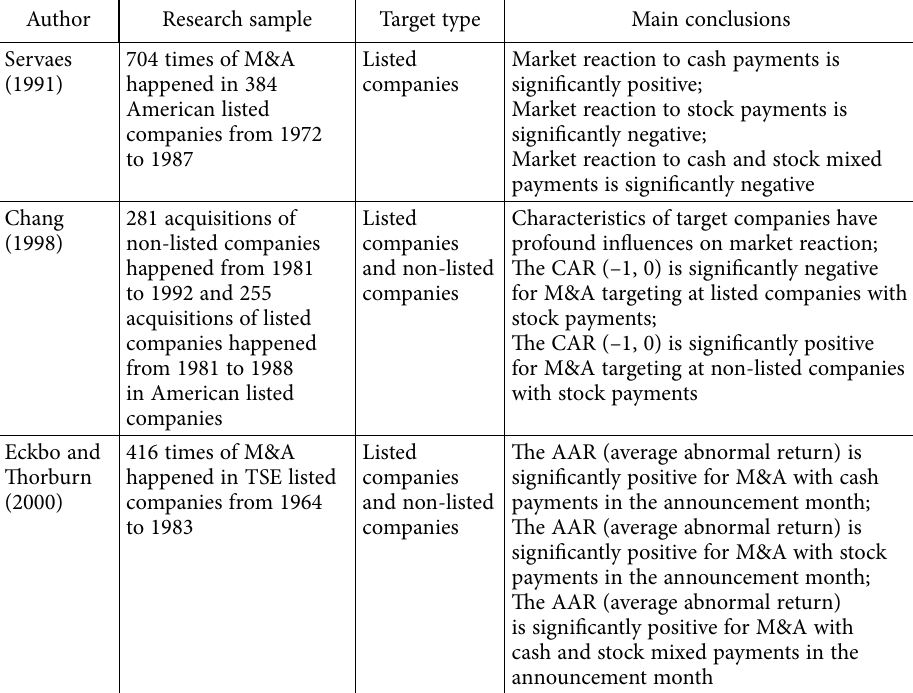
Table 2. Typical relevant empirical literature on the market reaction of bidders to payment